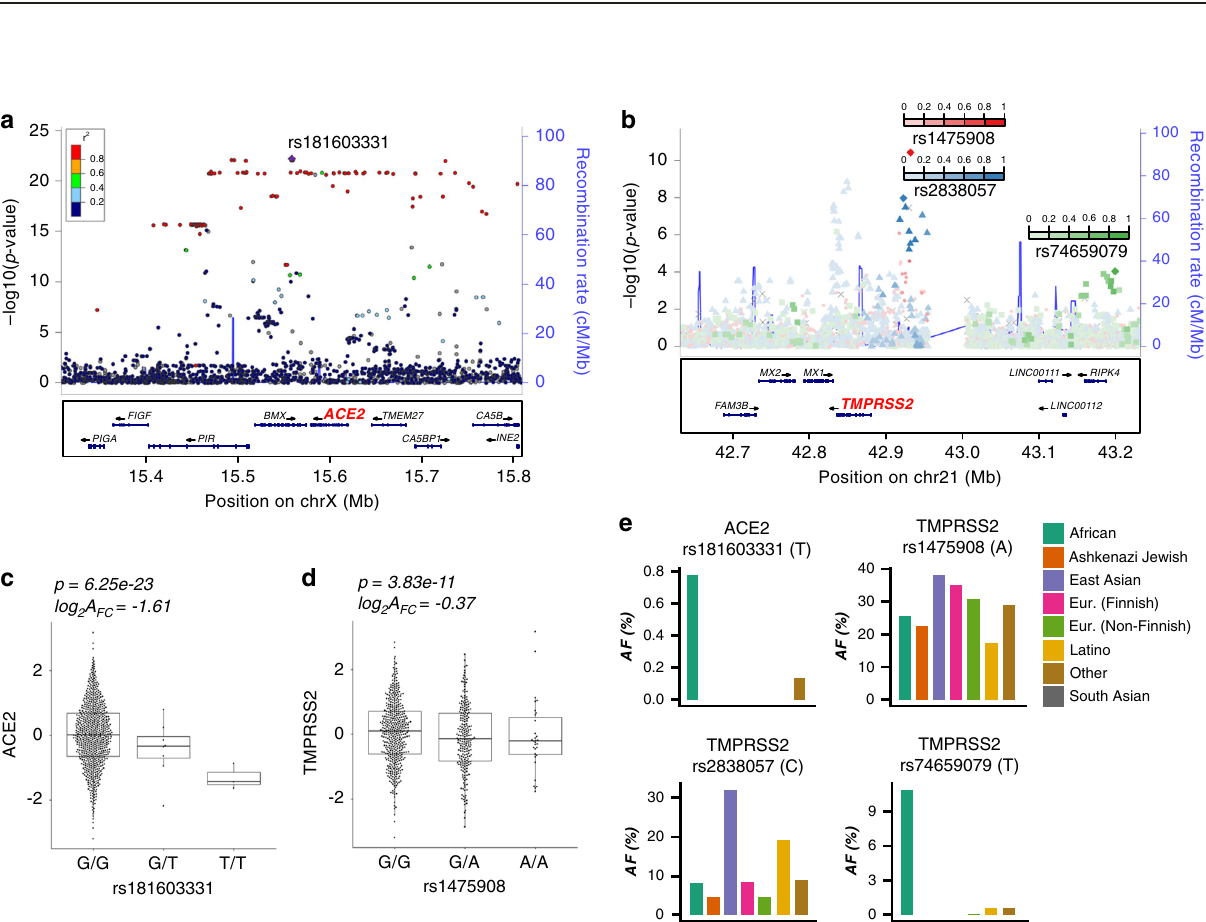
Fig. 5 Airway surface ACE2 protein is regulated by IL-13 and viral infection. a – c Immuno fl uorescence staining of in vitro nasal airway epithelial ALI cultures (derived from a single GALA II asthmatic child) derived from vehicle-treated ( a ), 5 days IL-13(10 ng mL − 1 ) treated ( b ), and 24 h HRV-A infected epithelium ( c ). Representative images of ciliated cells (ACT; red) and ACE2-positive (white) cells. The nuclei were counterstained with DAPI (blue). ACE2 protein was located in the apical compartment and decreased with IL-13 treatment and increased in HRV-A infection. Scale bars: 60 μ m. d Zoomed in image of c . e Quanti fi cation of apical ACE2-positive cells per 20x fi eld for each condition in the IL-13/HRV mature culture stimulation experiment ( n = 1 donor). p -values were obtained from a two-sided t -test. Data are presented as mean values ± SEM. f – h Immuno fl uorescence staining of in vitro nasal airway epithelial ALI cultures from a single child non-asthmatic donor derived from vehicle-treated ( f ), 21 days IL-13 (10 ng mL − 1 ) treated ( g ), and 21 days DAPT(5 μ M) treated epithelium ( h ). Representative images of ciliated cells (ACT; red), basal cells (KRT5; green), and ACE2-positive (white) cells. The nuclei were counterstained with DAPI (blue). ACE2 protein located in the apical compartment and decreased in IL-13 treatment and increased in DAPT treatment. Scale bars: 60 μ m. i Quanti fi cation of apical ACE2-positive cells per 20x fi eld for each condition in the IL-13/DAPT differentiation experiment ( n = 1 donor). p -values were obtained from a two-sided t -test. Data are presented as mean values ± SEM. j Immuno fl uorescence staining of in vivo trachea tissues from a single healthy donor. Representative images of ciliated cells (ACT; red), basal cells (KRT5; green), and ACE2-positive (white) cells. The nuclei were counterstained with DAPI (blue). ACE2 protein located in the apical compartment of ACT positive ciliated cells. Scale bars: 60 μ m. All images were captured on the Echo Revolve R4 and images were cropped and resized using Af fi nity Designer. For each image, brightness and contrasts were uniformly adjusted relative to the brightest feature to balance exposure of each color channel.